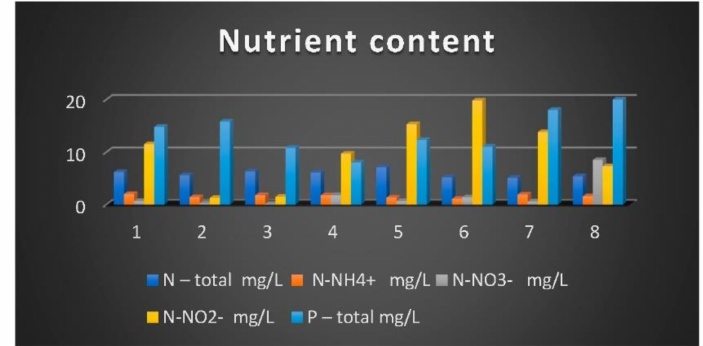
Figure 2. Nutrient content in the sewage sludge (quarterly average values).